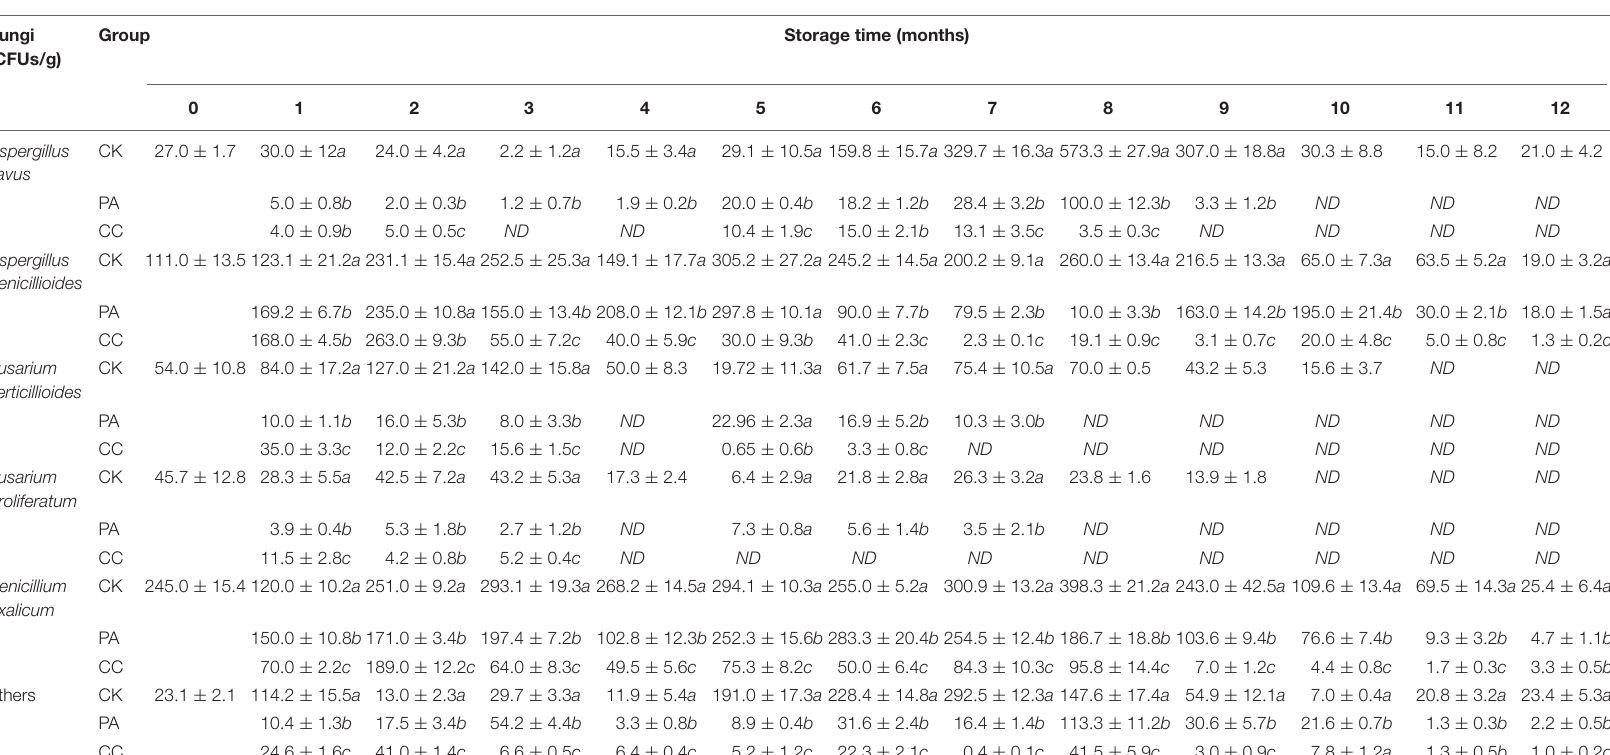
TABLE 1 | The colony-forming units (CFUs) of main fungi in stored maize treated with complex essential oils (CC), propionic acid (PA), and untreated (CK). Fungi (CFUs/g)